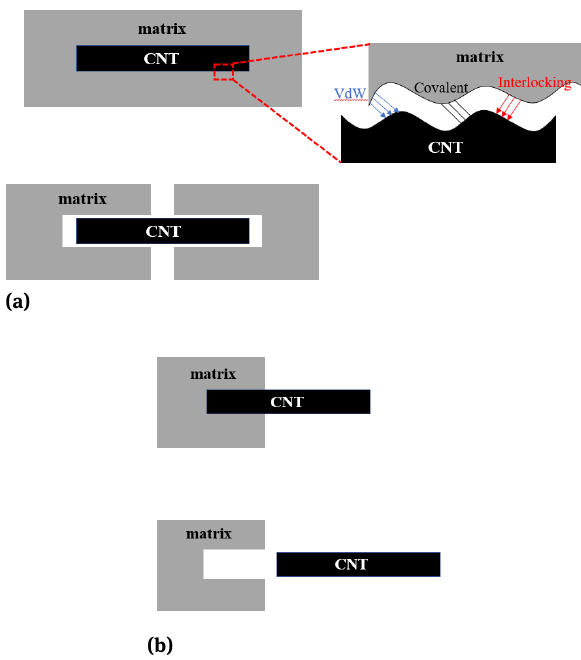
Figure 9: (a) Unpulled out CNT and the bonding mode between MWCNTs and matrix; (b) CNT be pulled